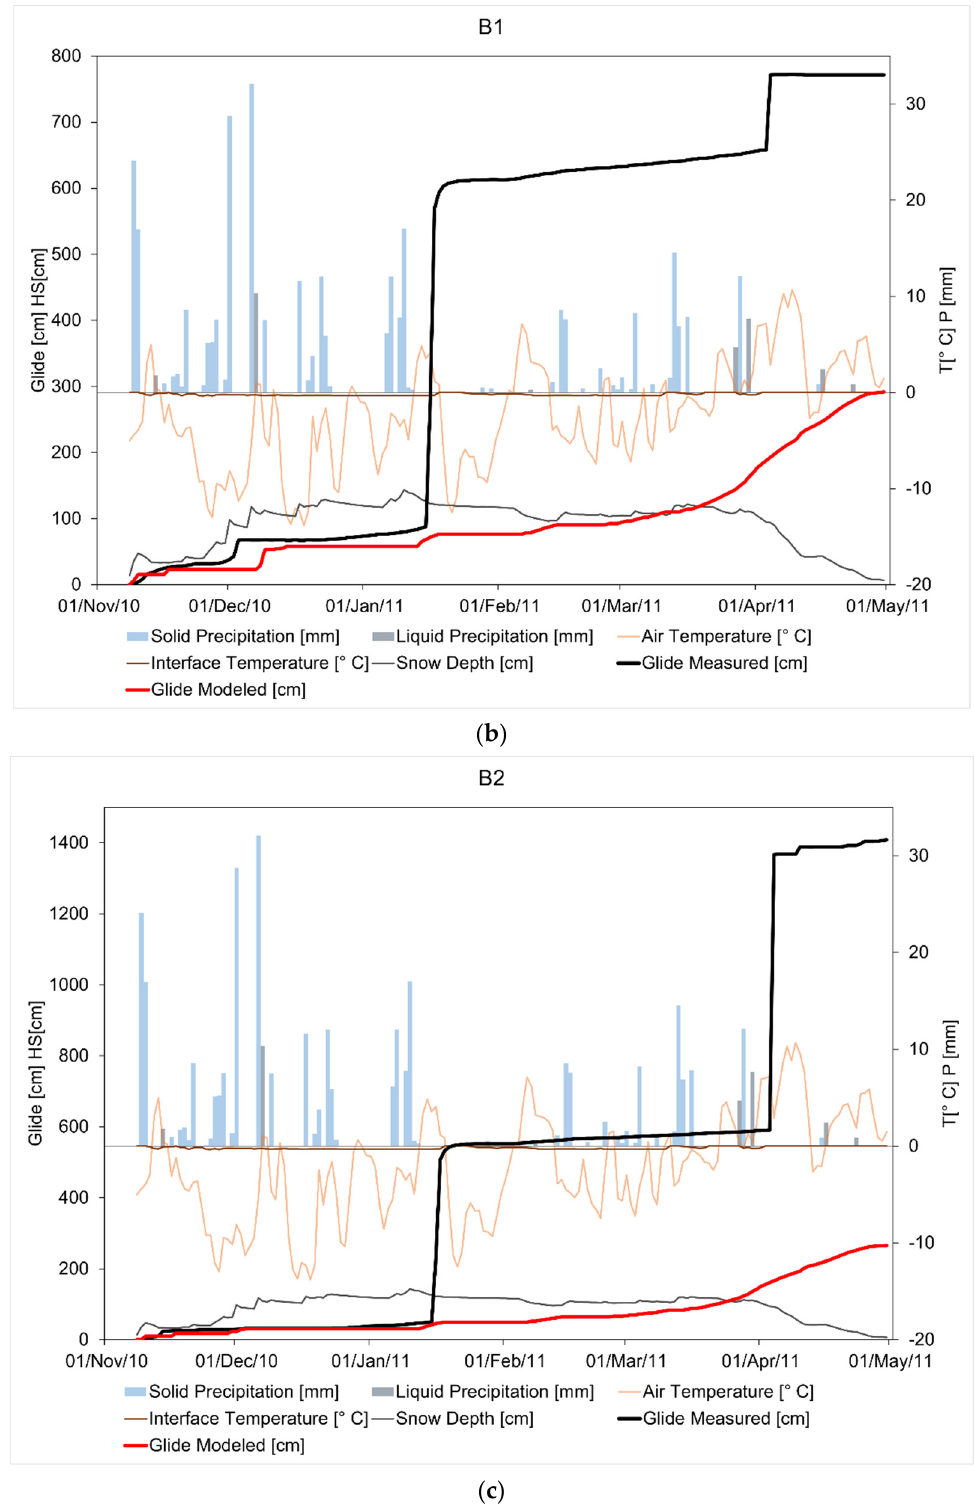
Figure 4. Cumulative glide measured and modeled, with information of solid and liquid precipitation, temperature of air and of soil and snowpack depth for the season of 2011. ( a ) A1. ( b ) B1. ( c ) B2.